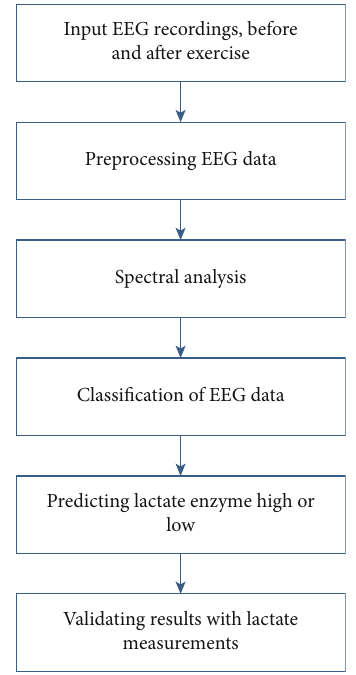
Figure 1: The proposed classi fi cation